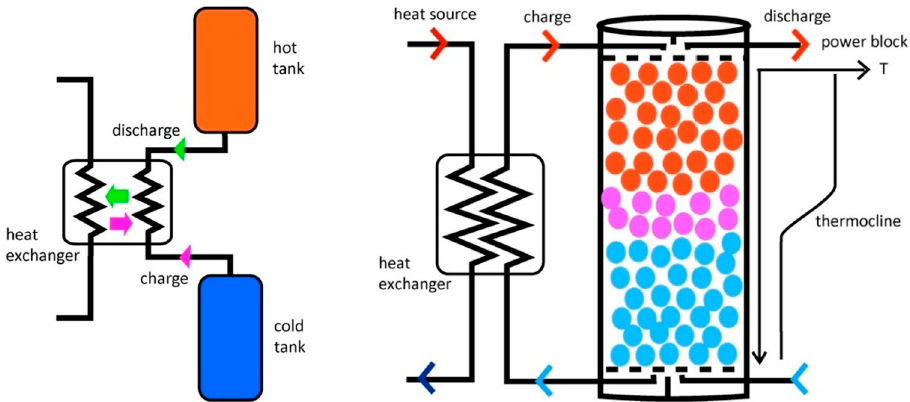
Figure 6. Two-tank indirect ( left ) and one-tank thermocline storage system ( right ). Reprint with permission [130]; 2017, Elsevier.